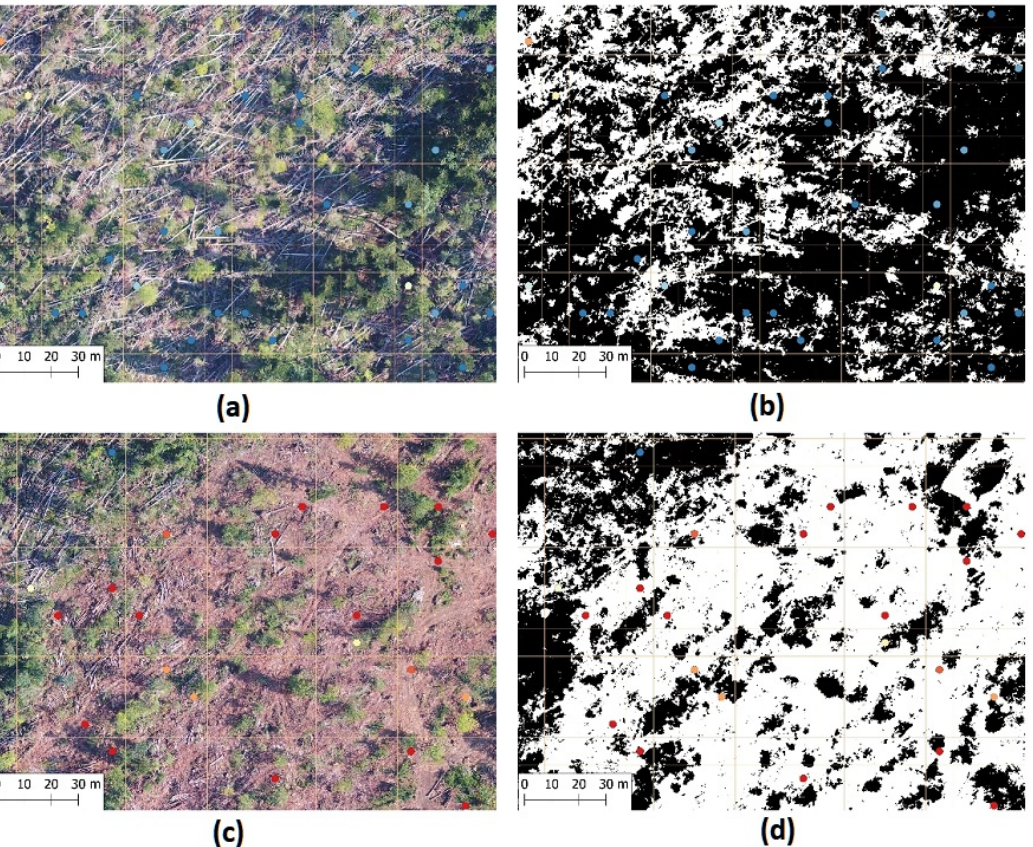
Figure 9. Deeper insight into two contrasting areas. ( a ) An area with fallen trees after a windstorm; ( b ) comparative UAV mask that overestimates real forest cover; ( c ) forest clearing with removed logs and noticeable bare ground with distinguishable soil color; ( d ) comparative UAV mask of the forest clearing with scarce canopy cover.